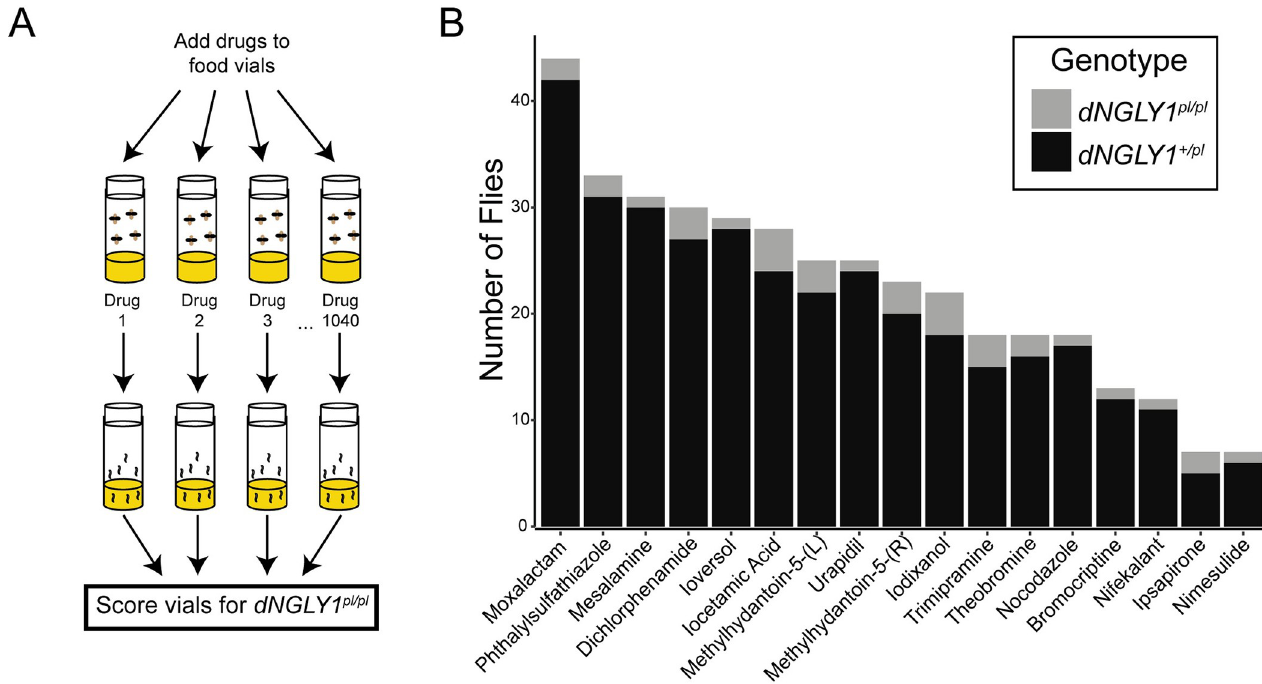
Fig 1. Workflow and results of the in vivo , small molecule screen. A) Screening strategy to identify compounds that rescue lethality in dNGLY1 pl/pl flies. B) Seventeen hit compounds were identified from the 1040 compounds screened from the Prestwick Chemical Library. Total fly counts for each drug treatment in the primary screen, with the dNGLY1 pl/pl genotype in grey and heterozygous dNGLY1 +/pl genotype in